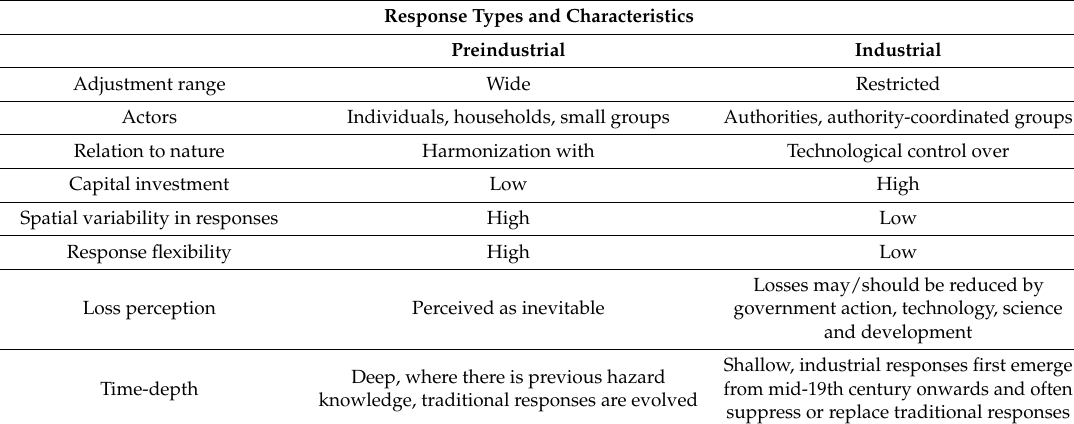
Table 1. Pre-industrial and industrial responses to natural hazards, adapted from White (1974). According to White, only Iceland comes close to have integrated the two resilience